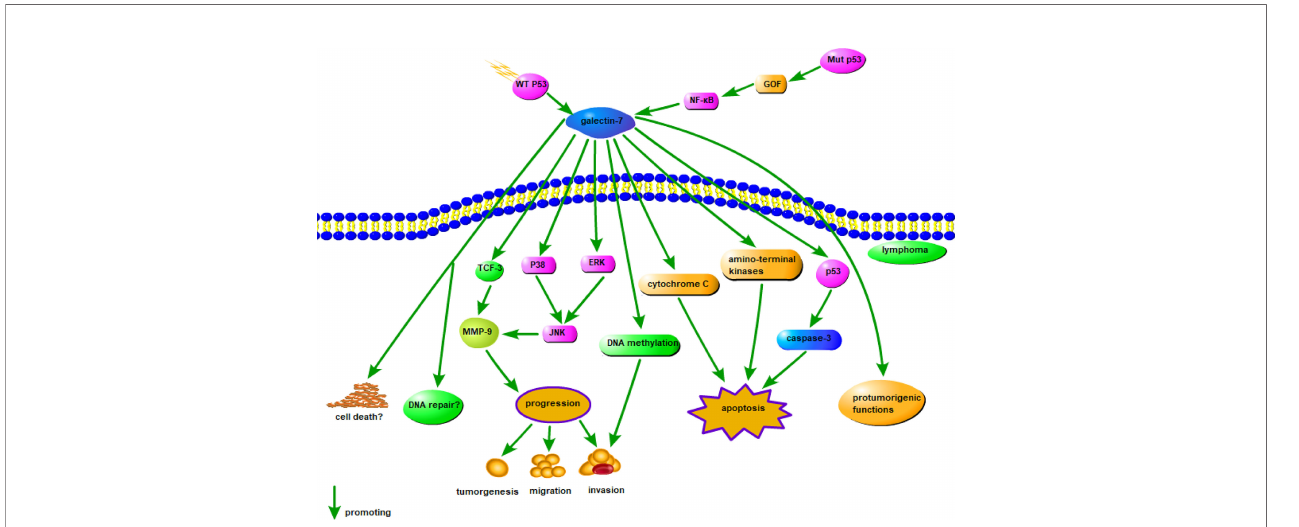
FIGURE 3 | Possible mechanism of galectin-7 in lymphoma. MMP-9 overexpression is signi fi cantly related to the aggressive progression of lymphoma, and intracellular galectin-7 increases MMP-9 expression by TCF-3, while extracellular increases MMP-9 expression through P38, ERK, and JNK pathways. WT p53- induced galectin-7 expression induced by post-stress signaling can regulate cell death and/or DNA repair, and in cancer cells, galectin-7 can be induced by mutation p53 by a gain-of-function (GOF) mechanism, shifting balance to pro-tumor effects. In addition, DNA methylation, cytochrome C and amino-terminal kinases may also cause apoptosis by the action of